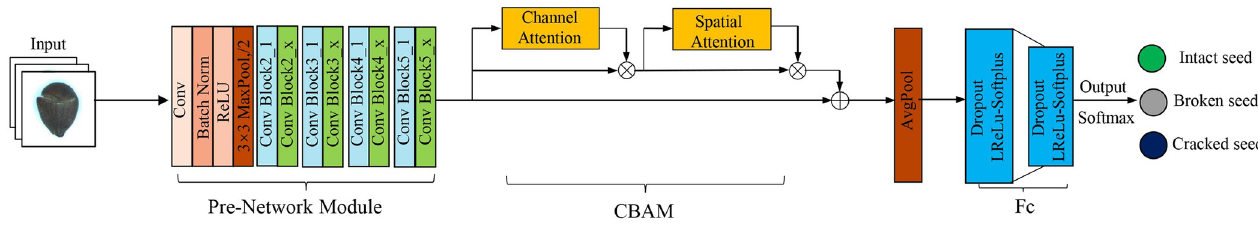
Fig 5. The improved ResNet50